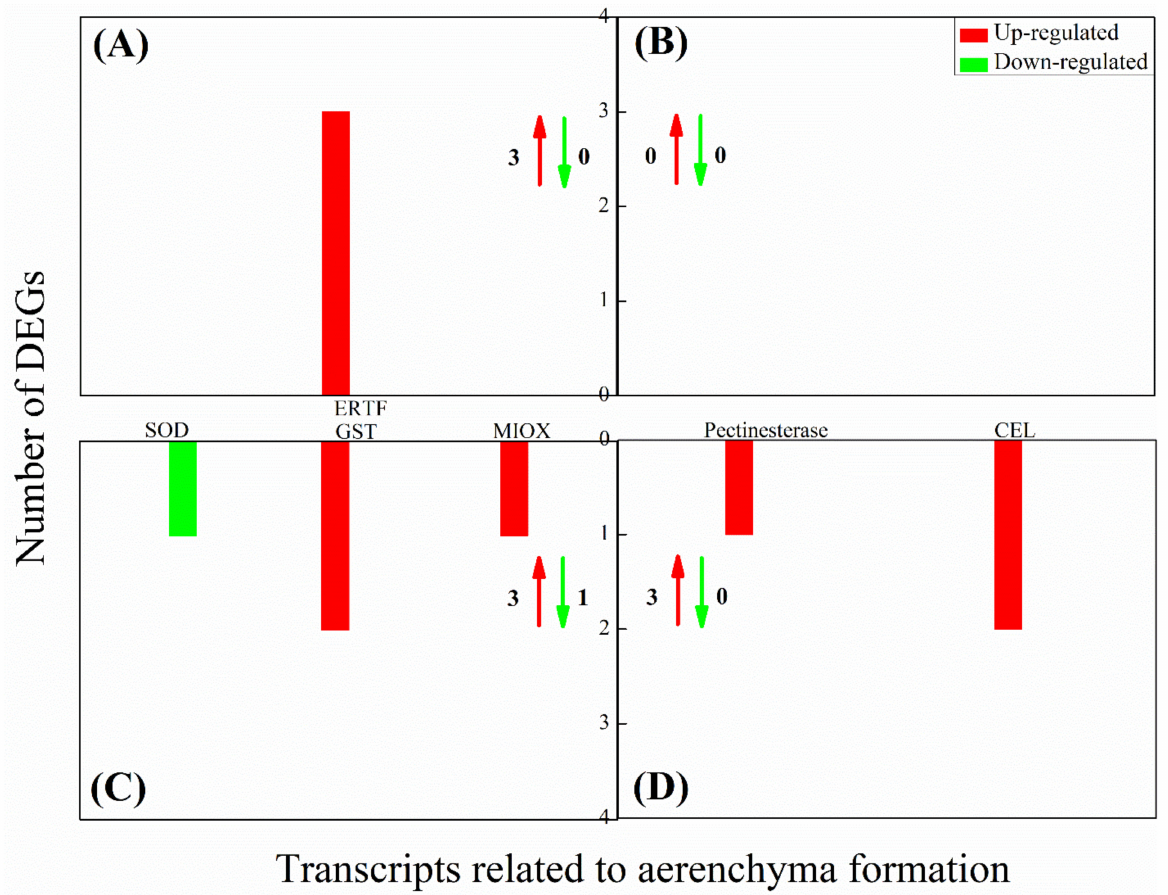
Figure 7. The expression of differentially expressed genes (DEGs) related to aerenchyma formation (ethylene signaling ( A ), calcium signaling ( B ), ROS generation/scavenging ( C ), and cell wall modification ( D )) in underground tissues of bermudagrass under deep submergence (DS). ERTF: ethylene-responsive transcription factor; SOD: superoxide dismutase; GST: glutathione S-transferase; MIOX: myo-inositol oxygenase; CEL: